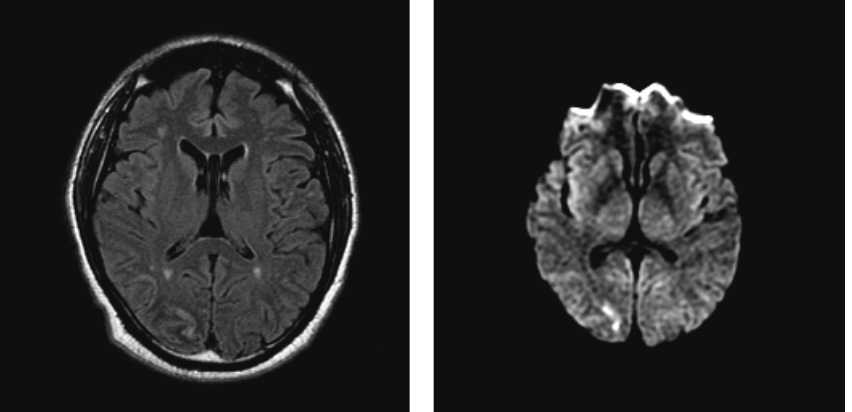
Figure 1: MRI 2 days after onset of symptoms, presenting acute occipitotemporal ischemic injury, corresponding to PCA territory sparing Brodmann area 17, and involving ventral portion of occipitotemporal projection; Brodmann areas 18 (parastriate) and 19